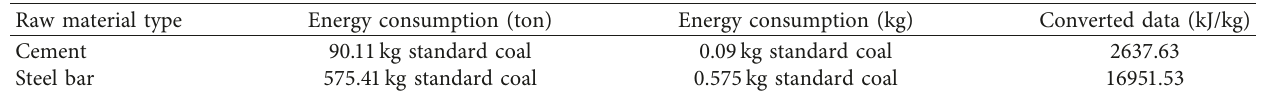
Table 8: Energy consumption to produce cement and steel bars in Nanjing [42].